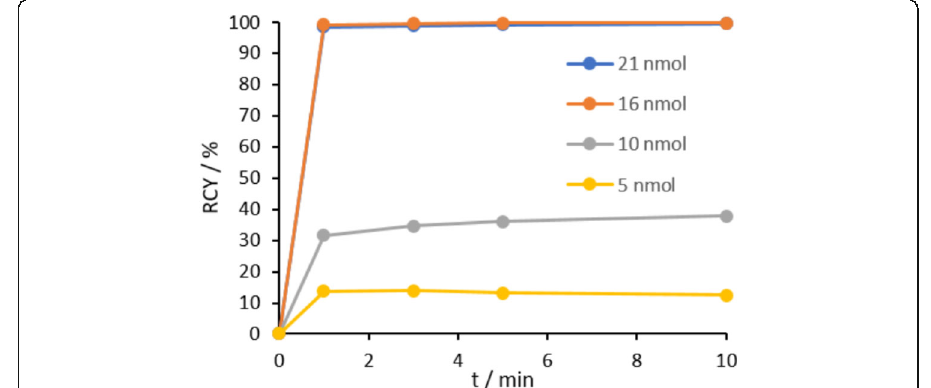
Fig. 6 Radiolabeling kinetics of various amounts of [ 68 Ga]Ga-DATA 5m .SA.FAPi complex at RT, precursor amounts > 15 nmol result in RCY > 98% after 15